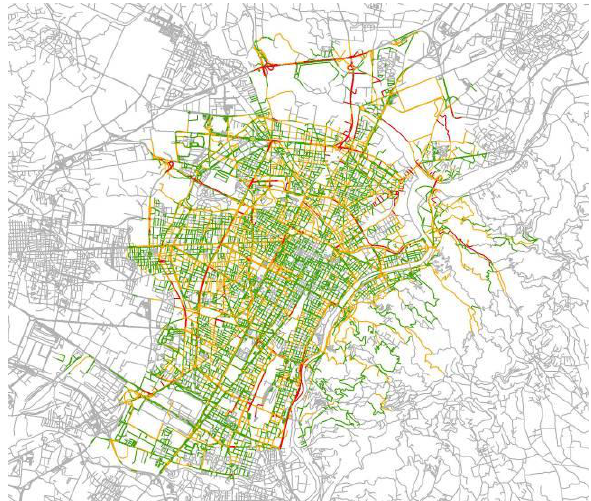
Figure 11 Vehicle flow during morning rush hour estimated from FCD